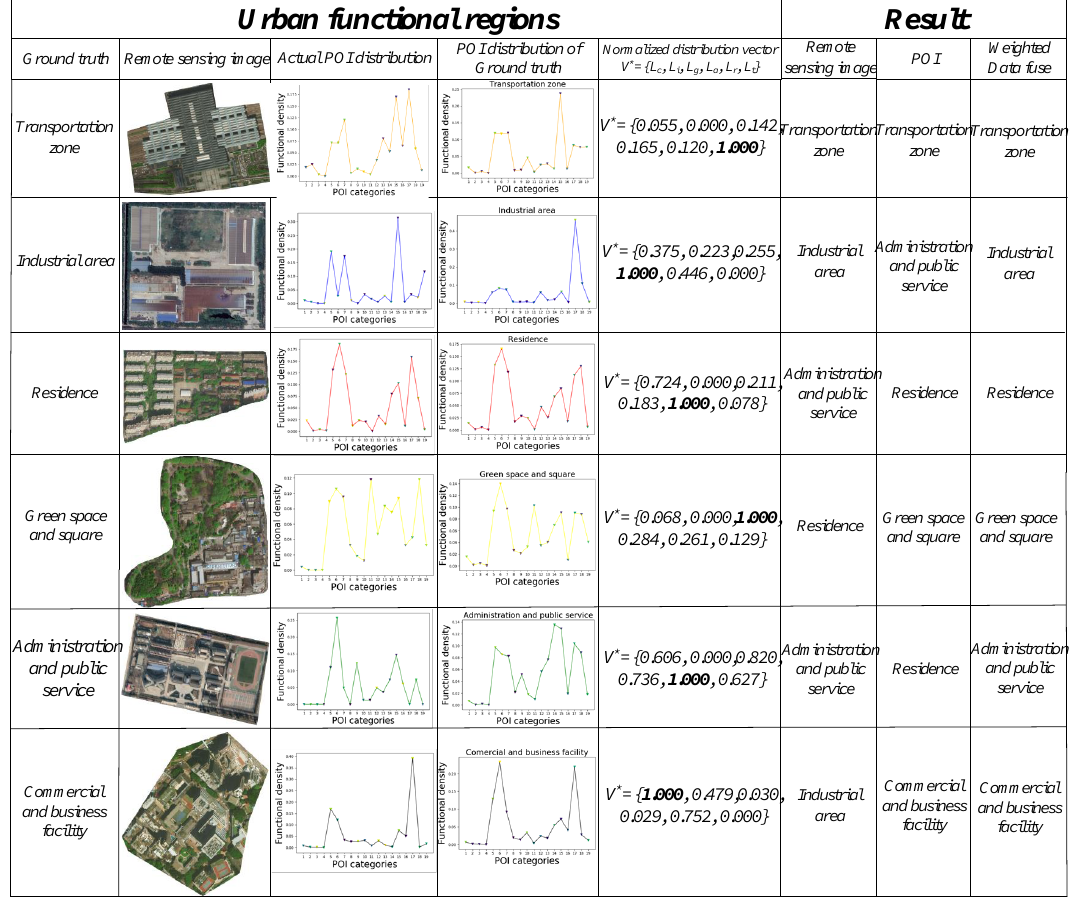
Figure 14. Some right examples of our proposed method in different situation. The ground truth represents the urban region function of example area. The remote sensing image represents the spatial geographic scenery of this area. The Actual POI distribution represents the actual POI distribution in this area. The POI distribution of ground truth represents the POI distribution in this urban functional region. The Normalized distribution vector V ∗ = { L C , L I , L G , L A , L R , L T } represents the similarity calculated by our distance metric method. In addition, the “C-Commercial and business facility”, “I-Industrial area”, “G-Green space and square”, “A-Administration and public service”, “R-Residence”, “T-Transportation zone”. The Result represents the identification of urban functional regions base on different data